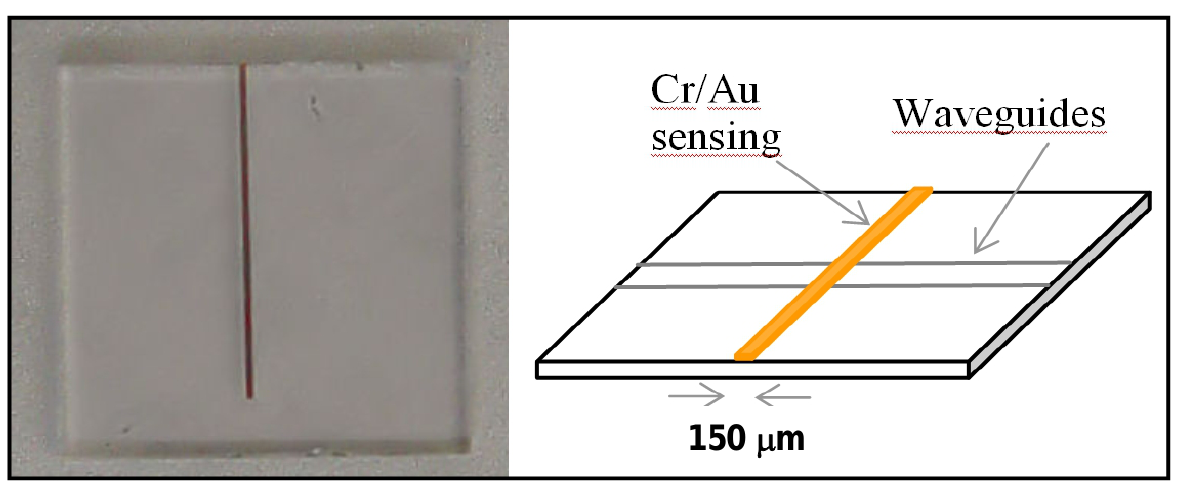
Figure 3. Photo and schematic of the glass sample region around the covering gold sensing window (channel waveguide is not visible, and this makes light coupling difficult).